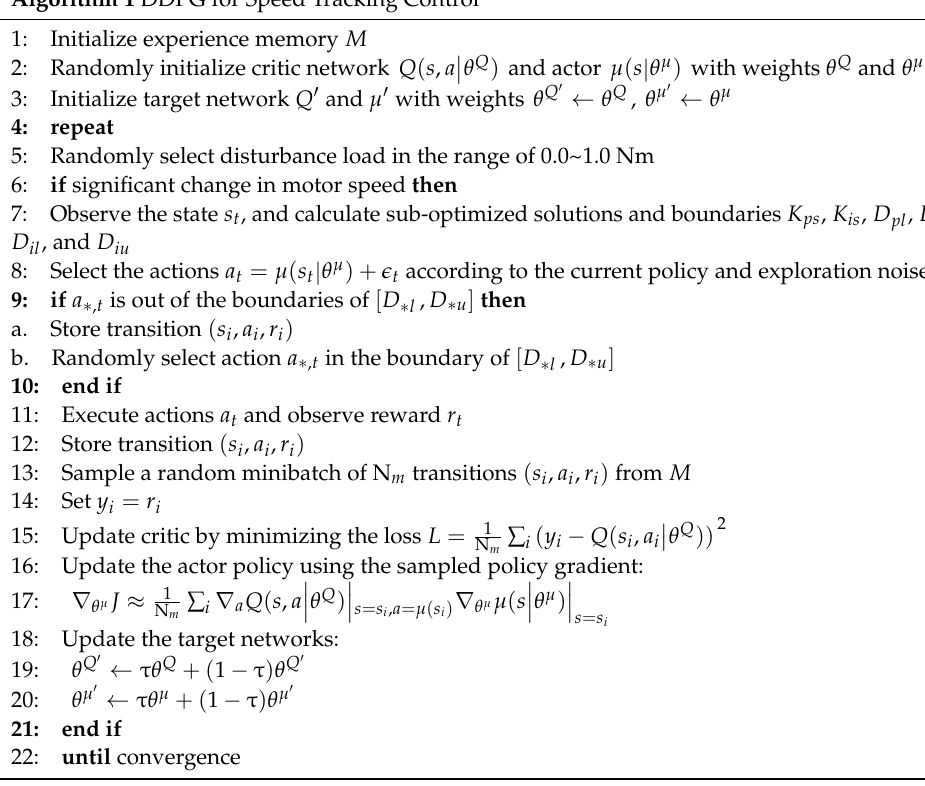
Algorithm 1 DDPG for Speed Tracking